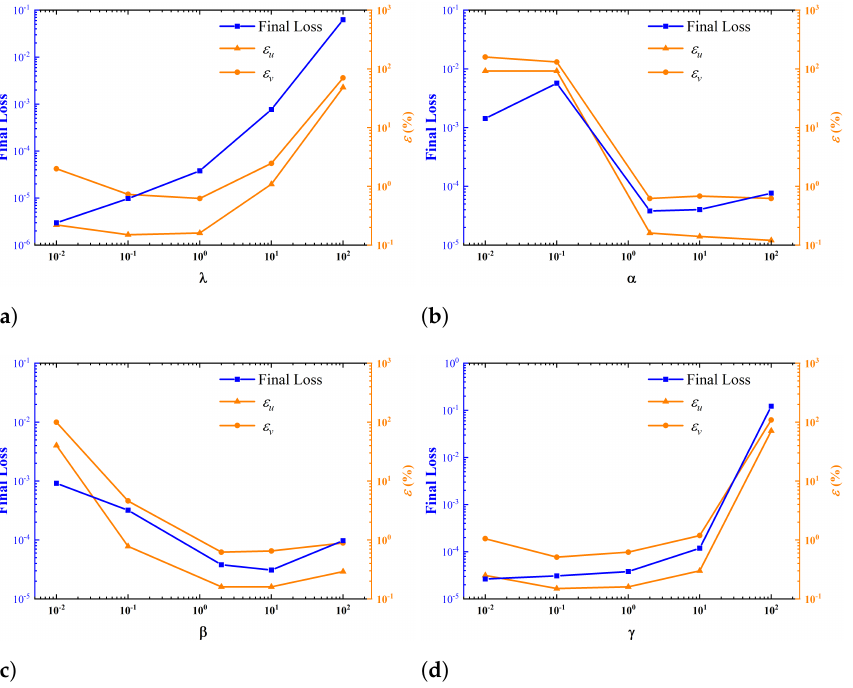
Figure 12. Influences of the weights on final loss and prediction error: ( a ) variable λ with α = 2.0; β = 2.0; γ = 1.0; ( b ) variable α with λ = 1.0; β = 2.0; γ = 1.0; ( c ) variable β with λ = 1.0; α = 2.0; γ = 1.0; ( d ) variable γ with λ = 1.0; α = 2.0; β =